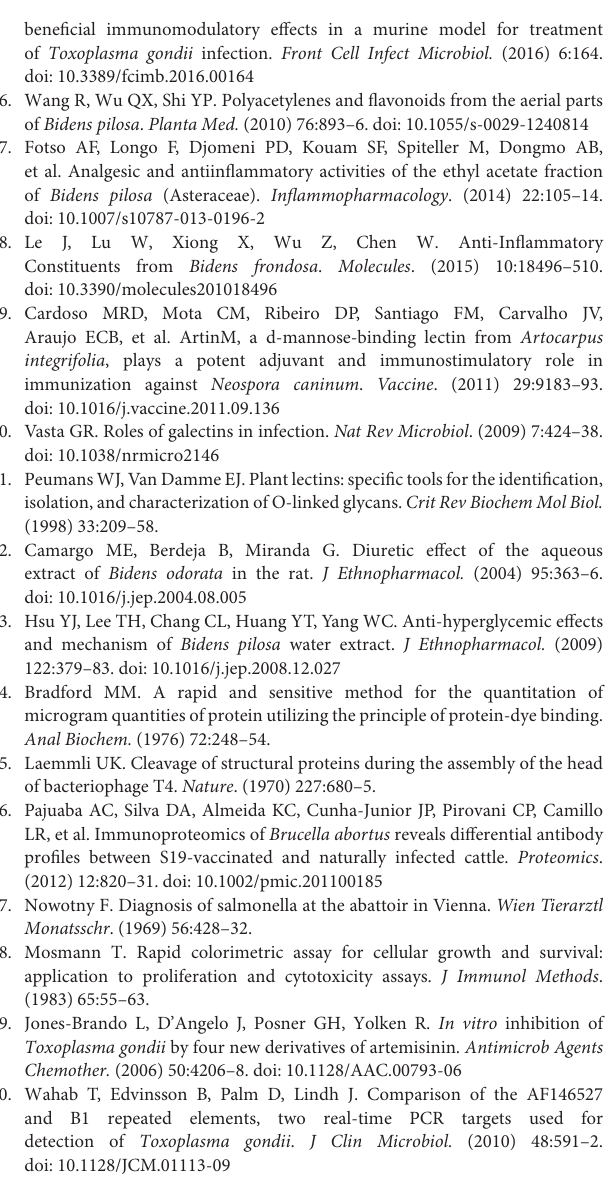
B. pilosa . Arrow—component identified as maturase k in the acetonic fraction from Bidens pilosa . Supplementary Table 1S | Analyses of Mass Spectrometry (MS) of Bidens pilosa acetonic fraction from two-dimensional and one-dimensional gel by NCBI Database